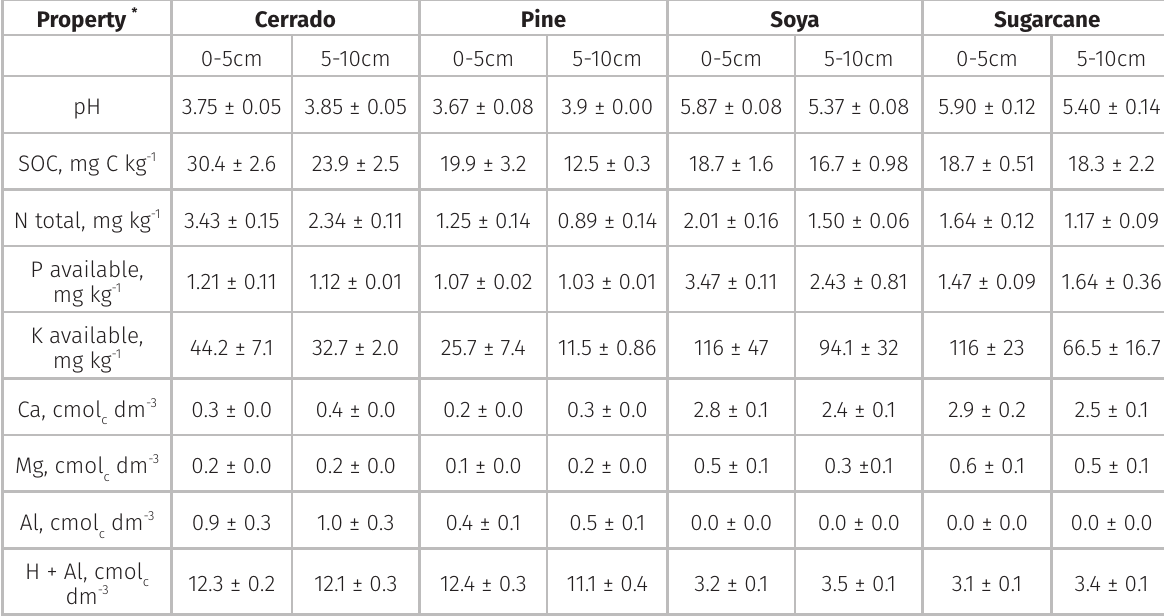
Table II. Physical and chemical properties (values a) of soils investigated in two depths and different land use systems in the Brazilian Savanna.